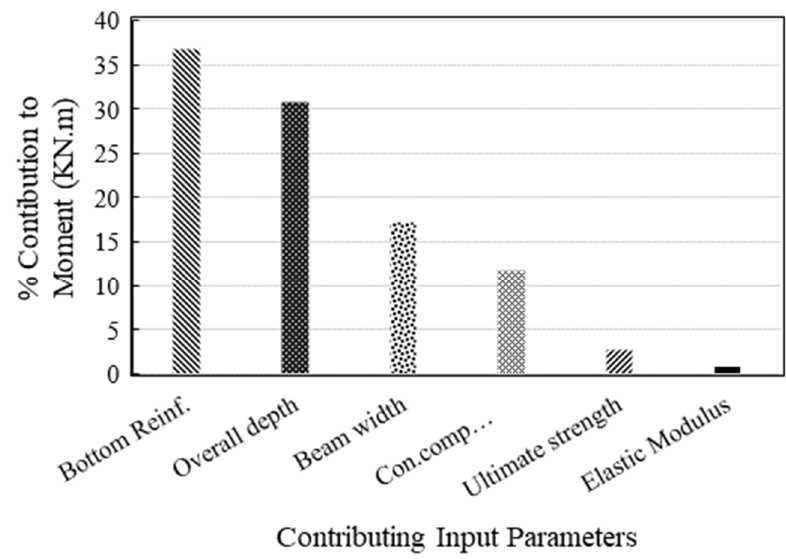
Polymers 2022 , 14 , x FOR PEER REVIEW Figure 4. Importance of the variables reflected from the ANN model. Figure 4. Importance of the variables reflected from the ANN model.